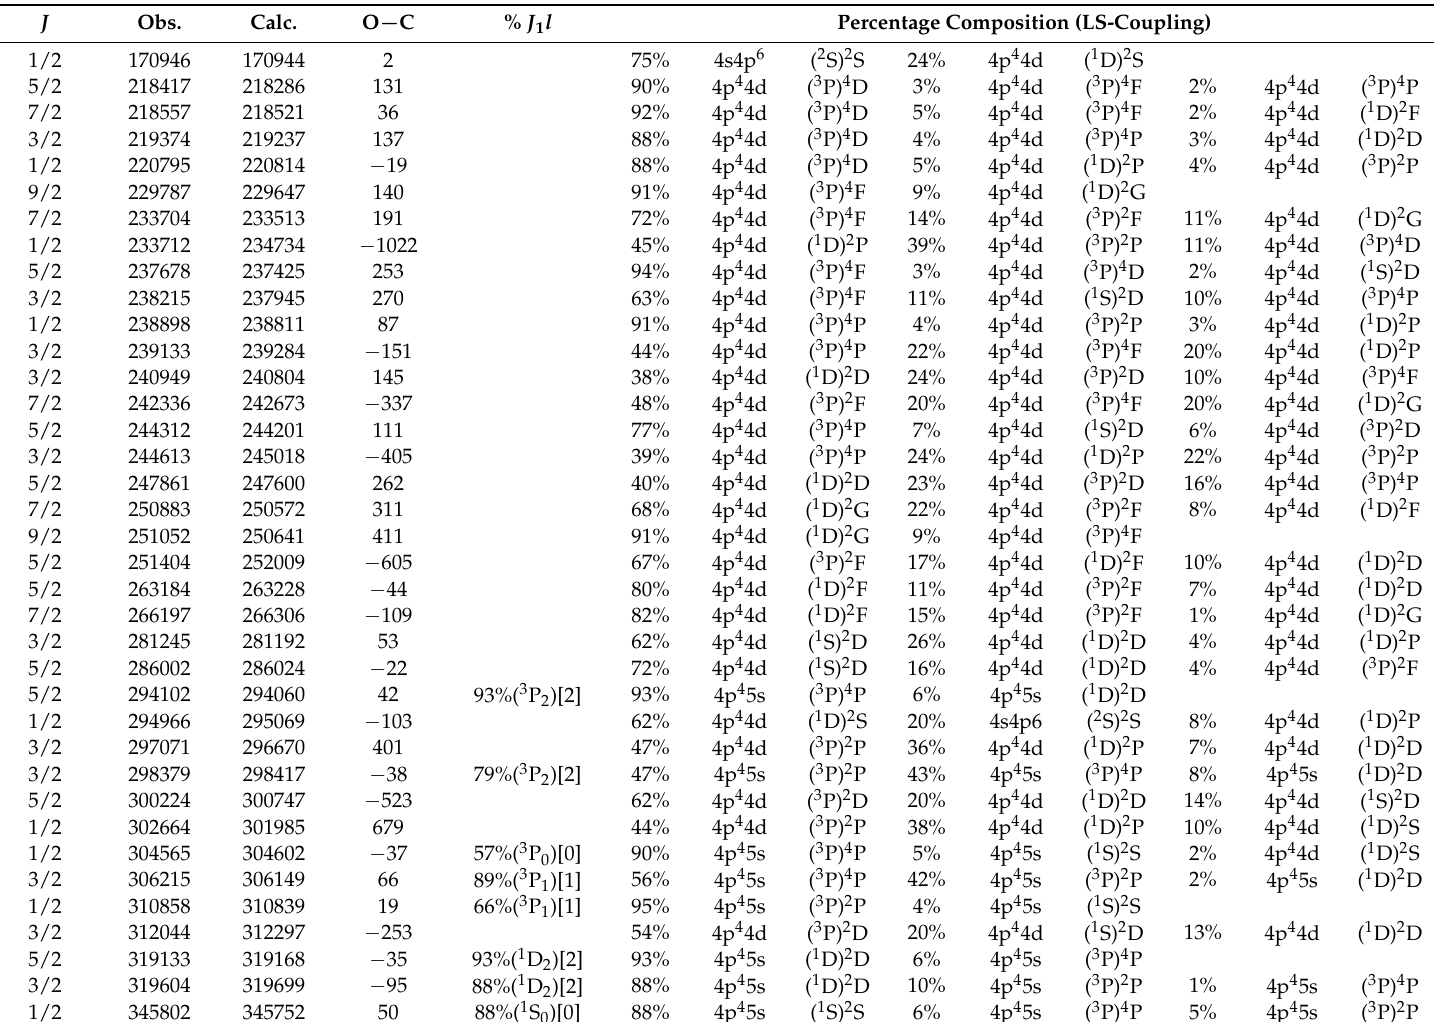
Table 7. Calculated energy levels (cm − 1 ) and percentage compositions for the even levels of Y